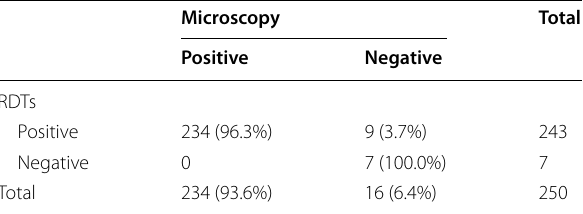
Table 2 Comparison of malaria test results for RDT and